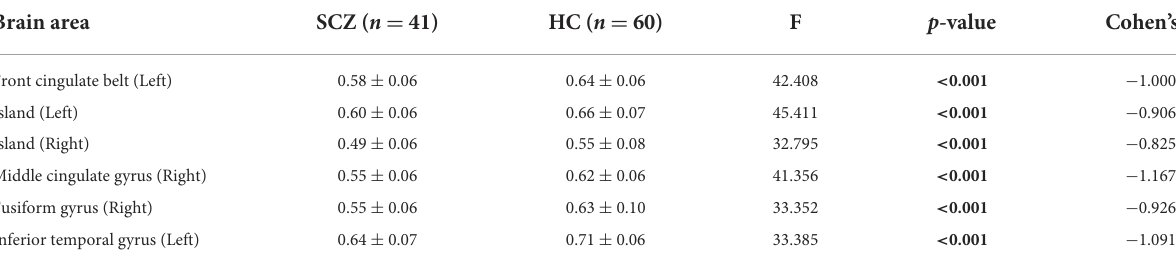
TABLE 3 The different brain areas of GMV between SCZ and HC. Brain area